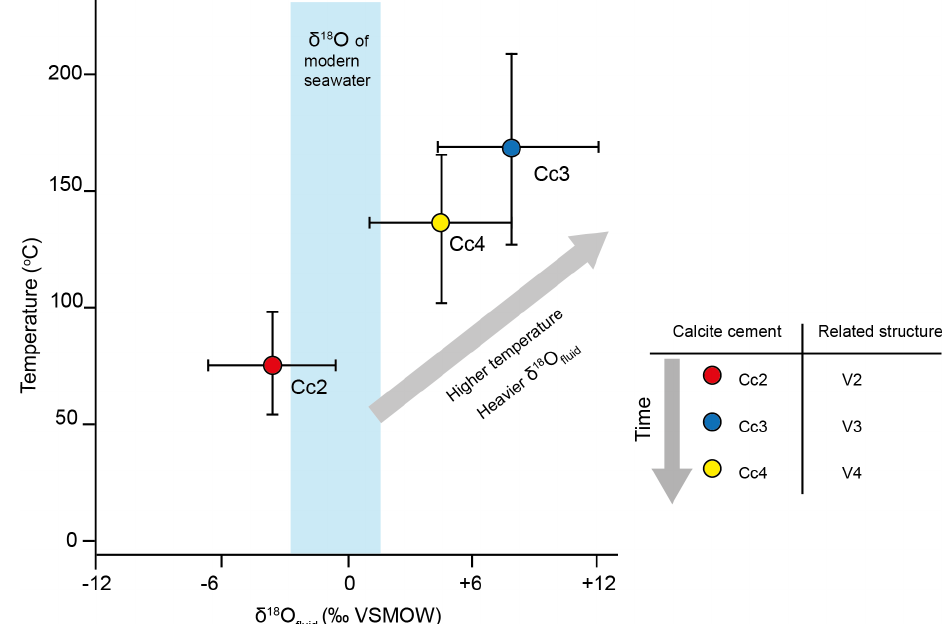
Figure 10. Temperatures ( ◦ C) vs. δ 18 O fluid calculated for cements Cc2 to Cc4. The typical δ 18 O values for modern seawater (blue band) are from Veizer et al. (1999).